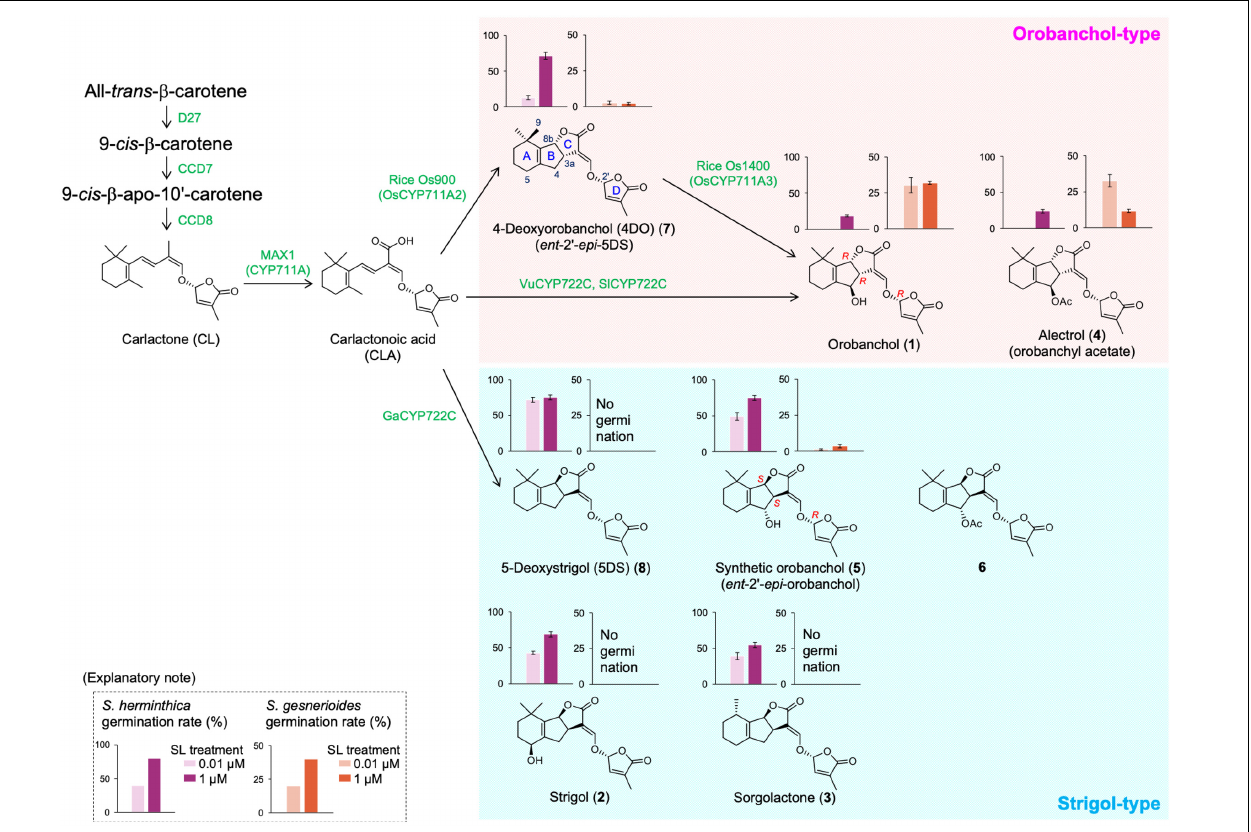
FIGURE 1 | Proposed strigolactone (SL) biosynthesis pathway from β -carotene and the seed germination induction of Striga by each SL. The sequential reactions catalyzed by D27, CCD7, and CCD8 enzymes produce carlactone (CL) from all- trans - β -carotene. CL is further converted to carlactonoic acid (CLA) by the CYP711A subfamily. Downstream of CLA, Os900/OsCYP711A2 in rice ( Oryza sativa ), VuCYP722C and SlCYP722C in cowpea ( Vigna unguiculata ) and tomato ( Solanum lycopersicum ), respectively, and GaCYP722C in cotton ( Gossypium arboreum ) can produce 4-deoxyorobanchol, orobanchol, and 5-deoxystrigol, respectively. The bar graphs at the top of each SL structure indicate the germination rates of S. hermonthica and S. gesnerioides induced by each SL as reported previously (Ueno et al., 2011b; Nomura et al.,